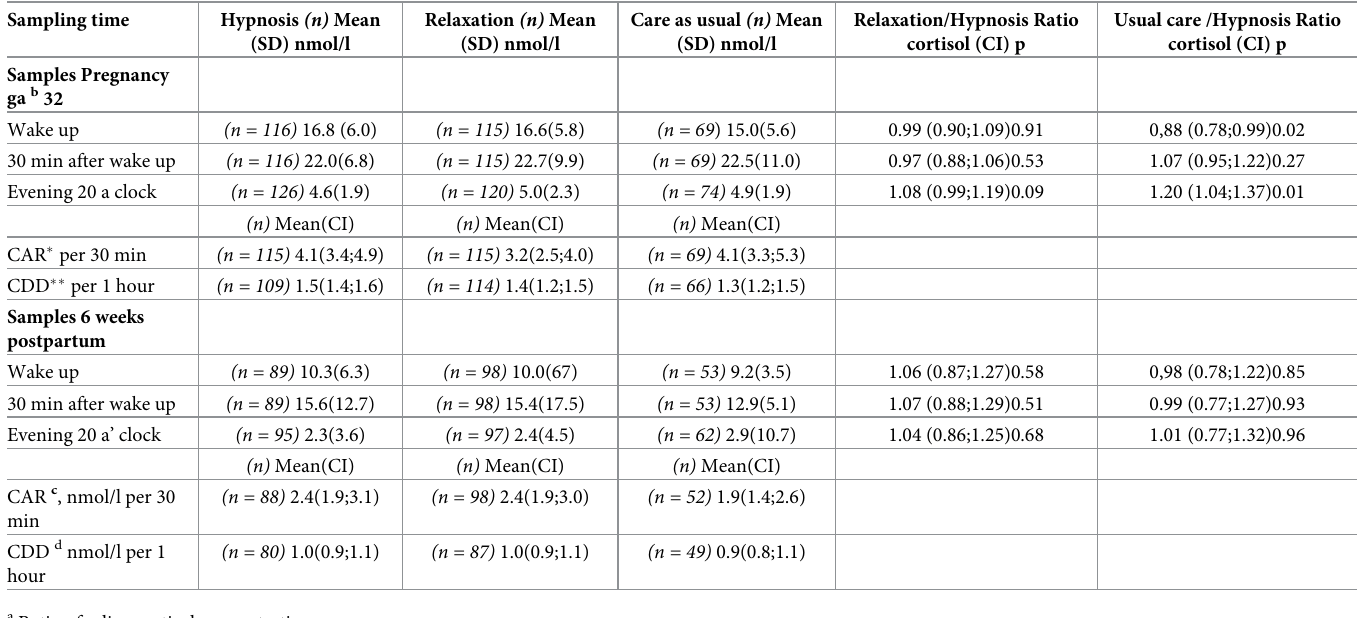
Table 2. Saliva cortisol concentration over the day according to randomization group and between group differences in pregnancy and 6 weeks postpartum. Sampling time